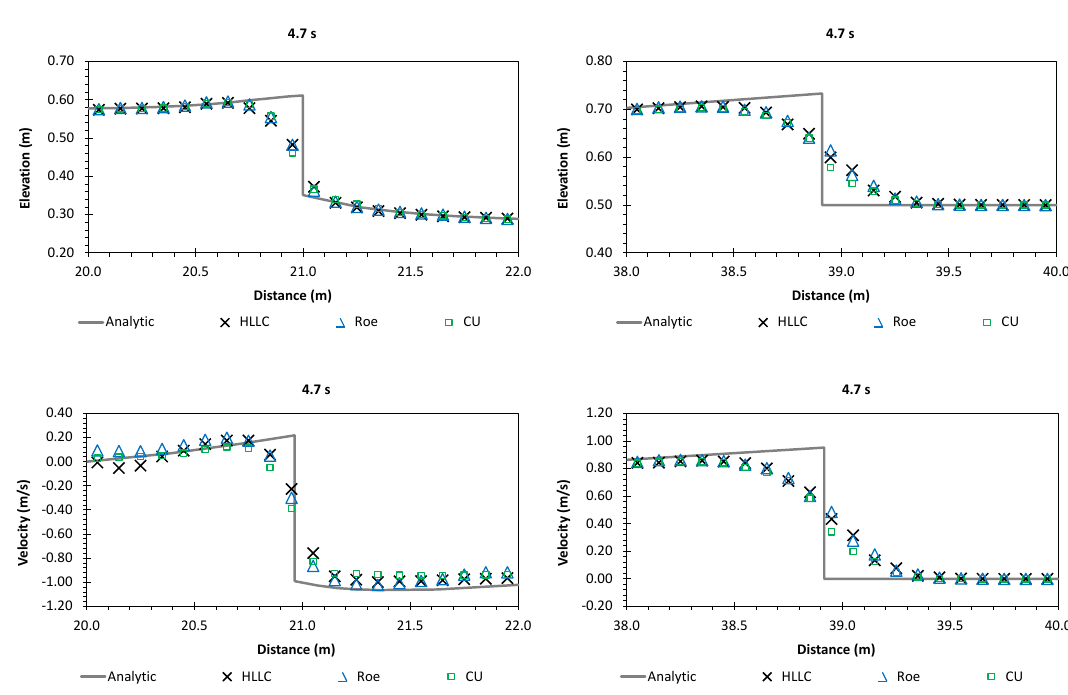
Figure 7. Case 1: comparison between analytical and numerical results at 4.7 s (in detail).